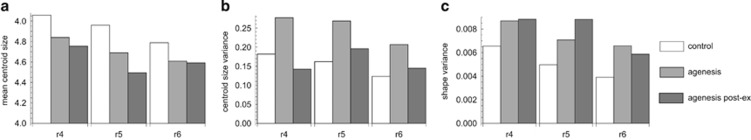
Mean centroid size (a), variance of centroid size (b) and total shape variance (c) of the three groups and the three dental regions (r4, r5 and r6).